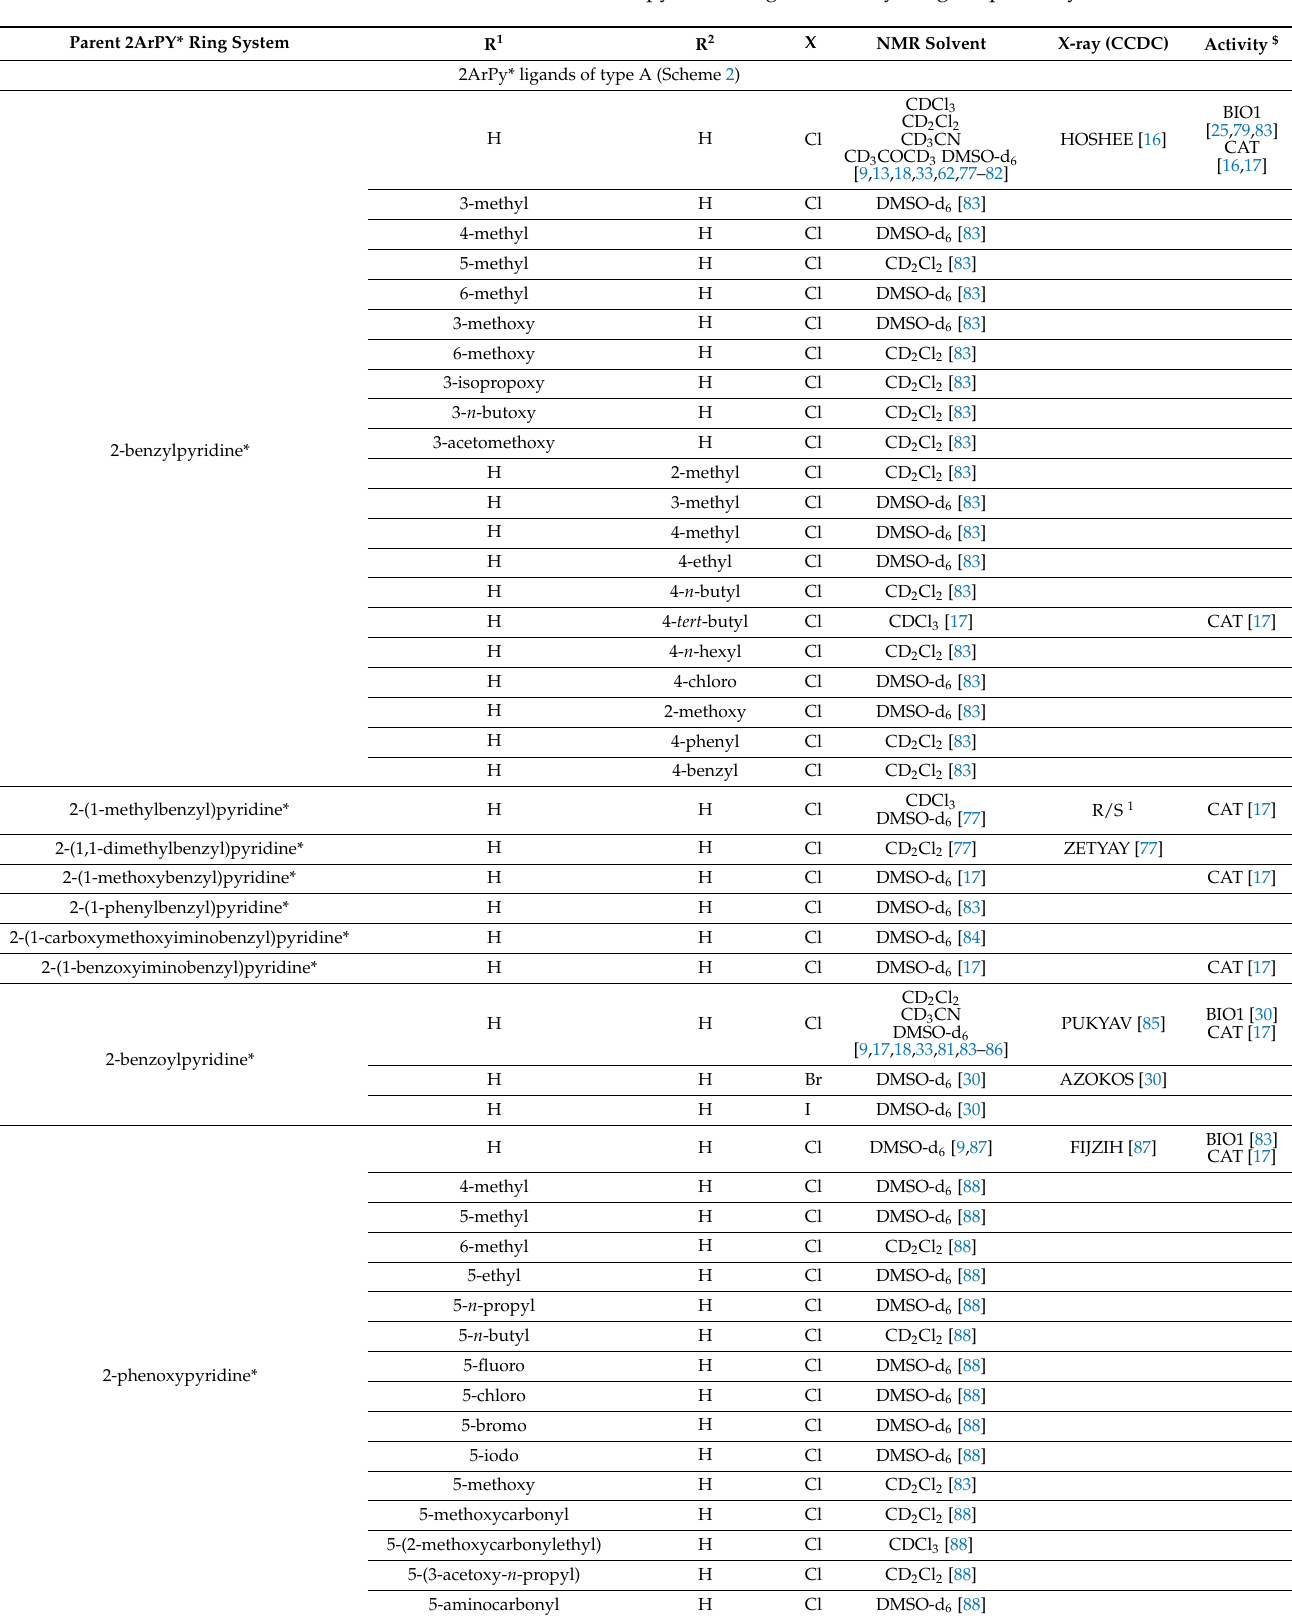
Table 4. NMR and/or X-ray studied [Au(2ArPY*)X 2 ] compounds (2ArPY* (cid:54) = 2PPY*; X = F, Cl, Br, I); R 1 and R 2 are substituents in the pyridine ring and the aryl ring,